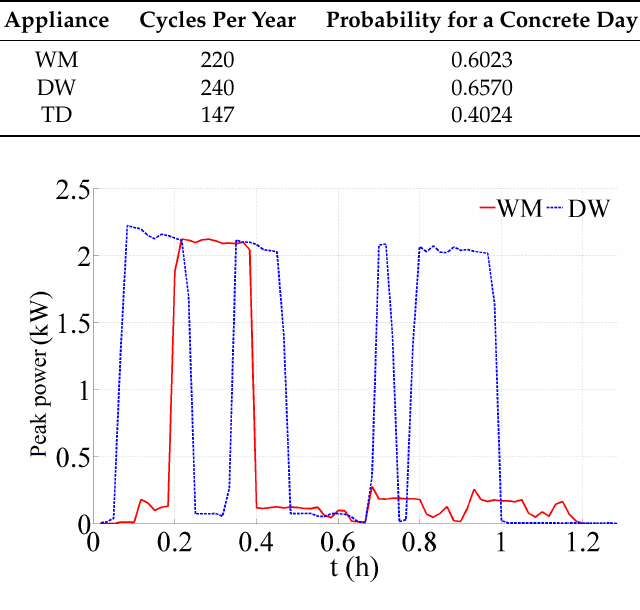
Figure 1. The detailed power cycles for the WMs and